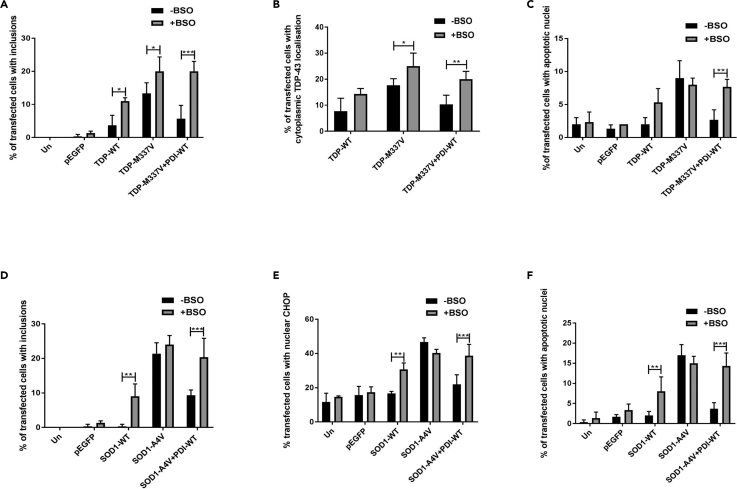
Depletion of Intracellular GSH Abrogates PDI's Activity against Mutant TDP-43 and Mutant SOD1(A) BSO treatment resulted in more cells forming TDP-43 inclusions in cells expressing TDP-43 WT or mutant TDP-M337V (∗p < 0.05), and those co-expressing mutant TDP-M337V with PDI-WT (∗∗∗p < 0.001), compared with DMSO treatment.(B) BSO treatment resulted in more cells with cytoplasmic TDP-43 in populations expressing TDP-M337V (∗p < 0.05) and those co-expressing PDI-WT with TDP-M337V (∗∗p < 0.01), compared with DMSO treatment.(C) BSO treatment resulted in more cells with apoptotic nuclei in populations co-expressing PDI-WT (∗∗p < 0.01) with TDP-M337V compared with DMSO treatment.(D) BSO treatment resulted in significantly more cells forming inclusions when PDI-WT was co-expressed with SOD1-A4V (∗∗∗p < 0.001), and in SOD1-WT-expressing cells (∗∗p < 0.01), compared with DMSO treatment.(E) BSO treatment resulted in more cells expressing nuclear CHOP when PDI-WT was co-expressed with SOD1-A4V (∗∗∗p < 0.001) compared with empty vector, and in cells expressing SOD1-WT (∗∗p < 0.01) compared with DMSO treatment.(F) BSO treatment resulted in more cells with apoptotic nuclei in populations expressing SOD-WT (∗∗p < 0.01) and those co-expressing PDI-WT with SOD1-A4V (∗∗∗p < 0.001), compared with DMSO treatment.